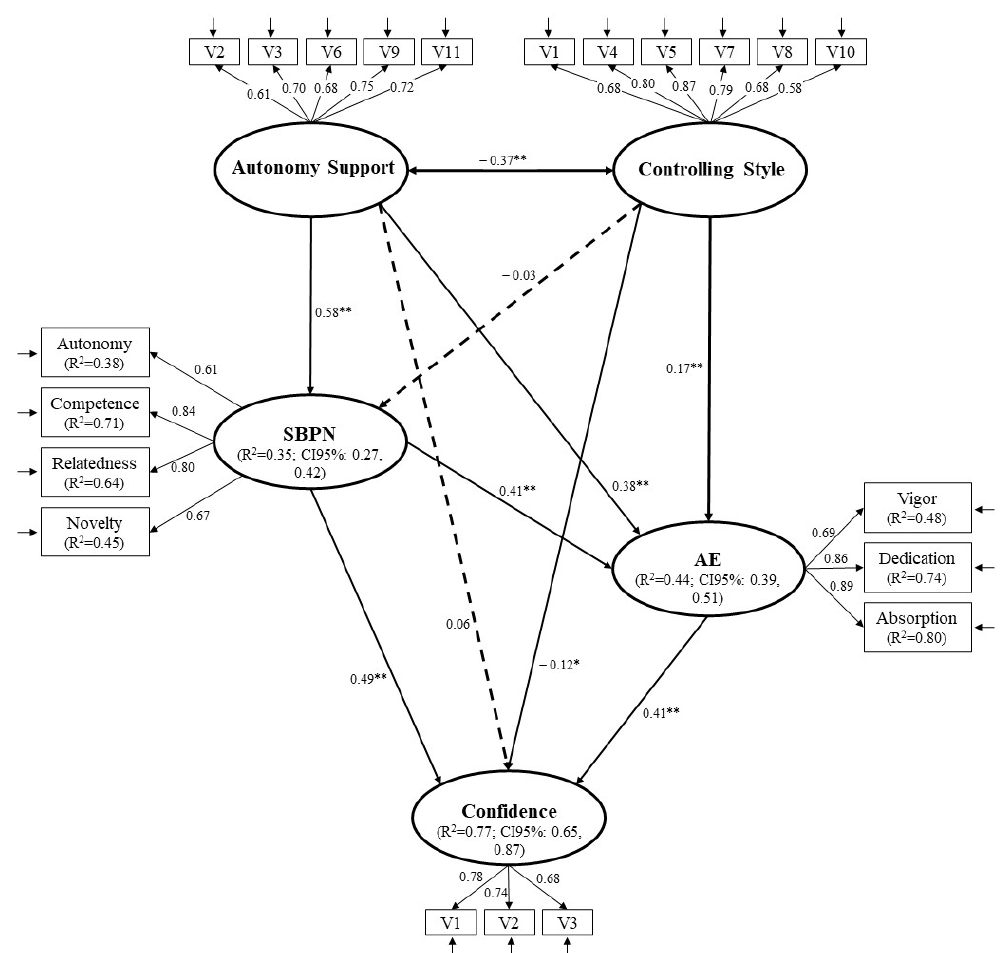
Figure 2. Predictive relationships between the interpersonal teaching style and academic confidence through the mediating role of the satisfaction of the basic psychological needs and academic en- gagement. Note: ** p < 0.001; * p < 0.01. SBPNs = Satisfaction of the basic psychological needs; AE = Academic engagement; R 2 = Explained variance; CI = Confidence interval. The dashed lines repre- sent non-significant relationships.